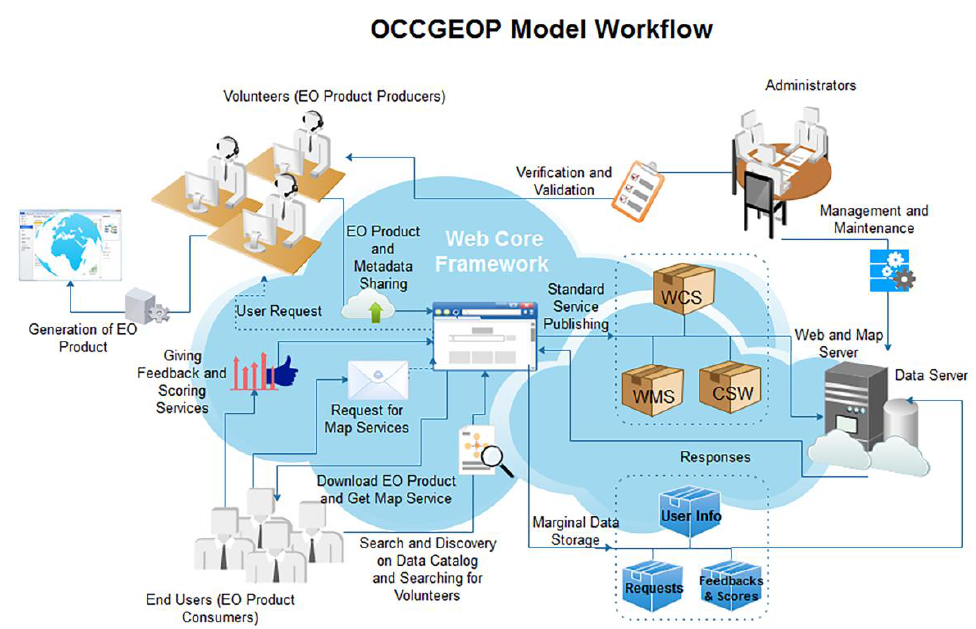
Figure 1. General workflow of the “Open Community-Based Crowdsourcing Geoportal for Earth Observation Products” (OCCGEOP) geoportal model.